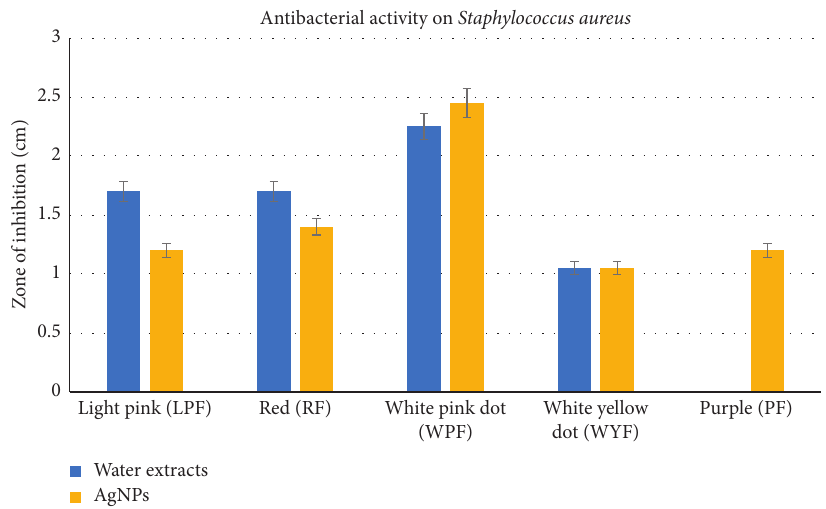
Figure 22: Antimicrobial activity of the water extracts and AgNPs against Staphylococcus